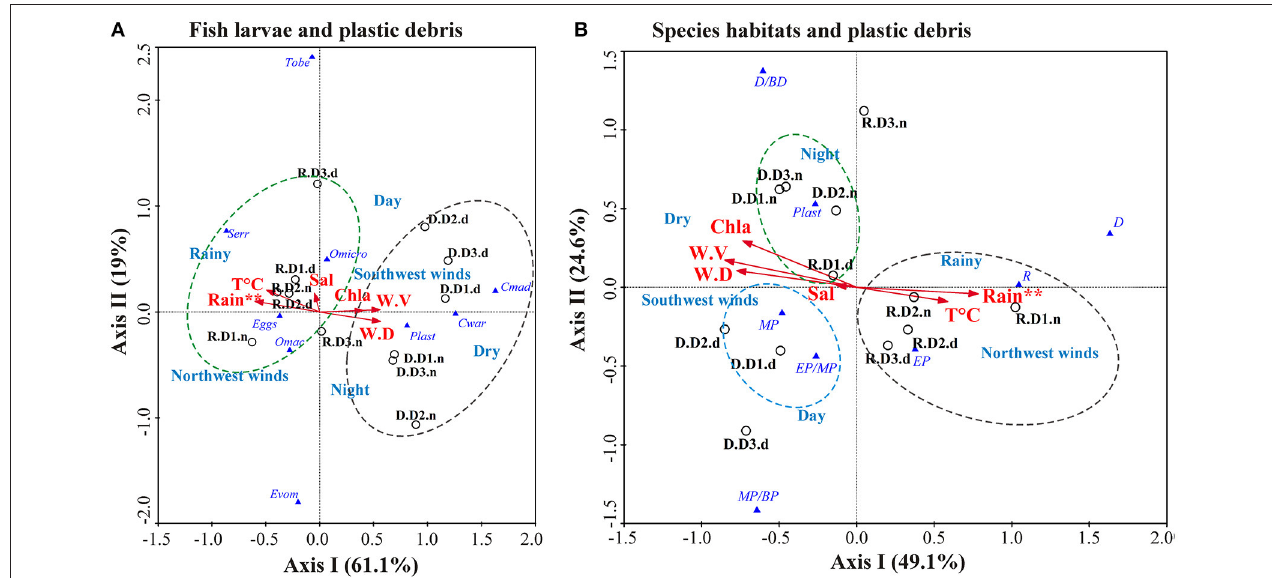
FIGURE 7 | Canonical correspondence analysis (CCA) triplot for the ecological correlations between the (A) ichthyoplankton/plastics and (B) larval assemblages/plastics and the oceanographic variables. Circles ( ◦ ) represent the three distances from the Archipelago [D1 ( < 100 m), D2 ( > 100–500m) and D3 ( > 500–1500 m)] during each season [R (Rainy season) and D (Dry season)] and period (d, day; n, night). Triangles ( ) represent the plankton [ichthyoplankton ( Cmad , Ceratoscopelus maderensis ; Cwar , Ceratoscopelus warmingii ; Eggs , fish eggs; Evom , Entomacrodus vomerianus ; Omac , Ophioblennius macclurei ; Omicro , Oxyporhamphus micropterus ; Serr , Serranidae spp.; Tobe , Thunnus obesus ), larval species habitats ( D , demersal; D / BD , demersal/bathydemersal; EP , epipelagic; EP / MP, epipelagic/mesopelagic; MP , mesopelagic; MP / BP , mesopelagic/bathypelagic; R , reef), and plastic debris ( Plast )]. The environmental variables [rainfall, chlorophyll a , salinity, temperature, wind direction (W.D.) and wind velocity (W.V.)] were represented by arrows. ** p <